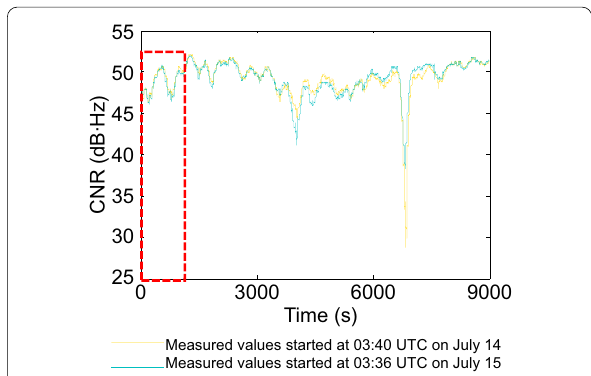
Fig. 11 CNR of PRN 6 in the first and second long-term measurements. The IF data collected between the start and second 1 200 highlighted by a red dot rectangle were solved with the narrow-spacing correlation, the MEDLL, and the proposed algorithm